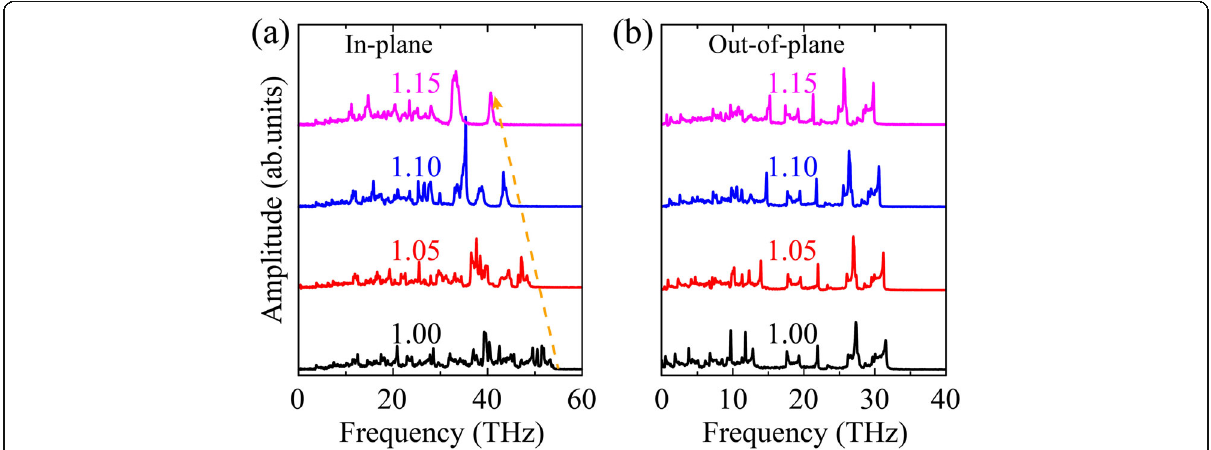
Fig. 11 In-plane a and out-of-plane b VDOS of OPG-L versus uniaxial tensile strain along the zigzag